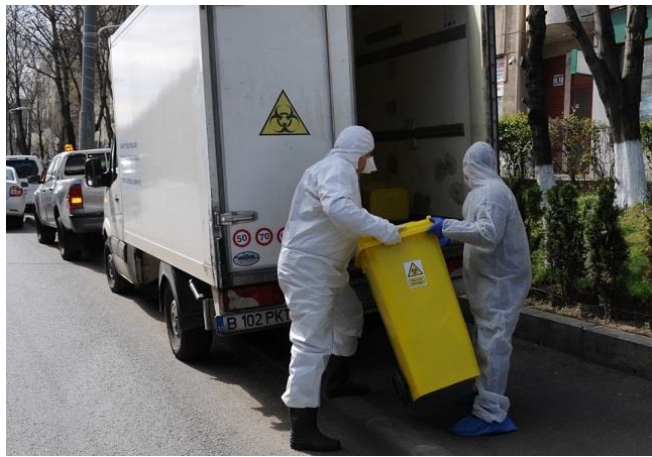
Figure 6. Collection of COVID-19 infectious waste in District 4 of Bucharest city Source: Bucharest District Hall 4.